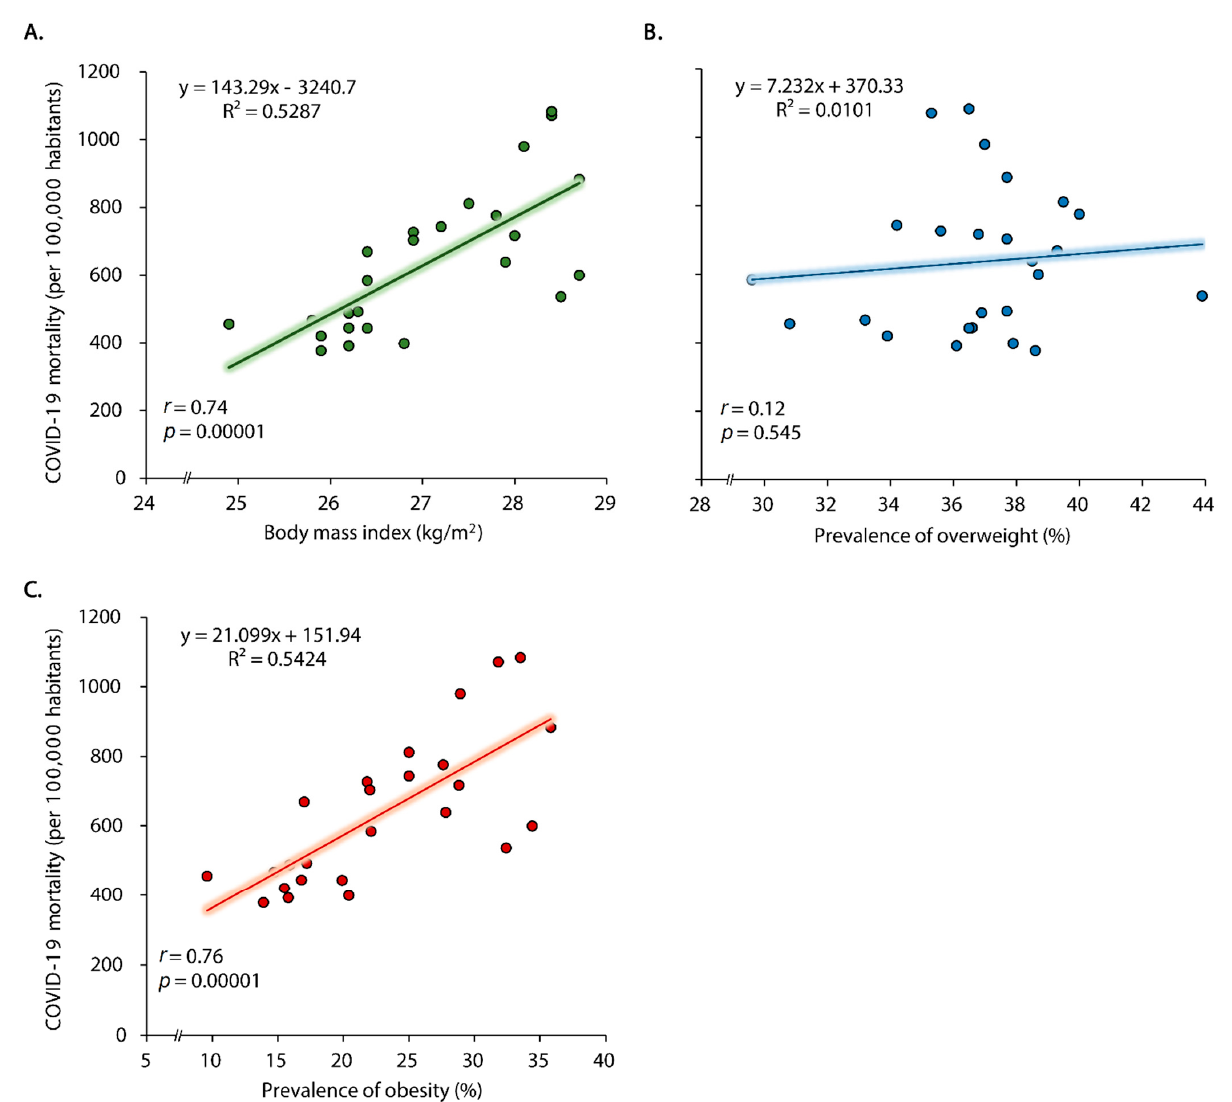
Figure 2. Correlation between body mass index (BMI) average ( A ), prevalence of overweight ( B ) and obesity ( C ) and mortality rates due to COVID-19 in Peru, March 2020 to June 2021.